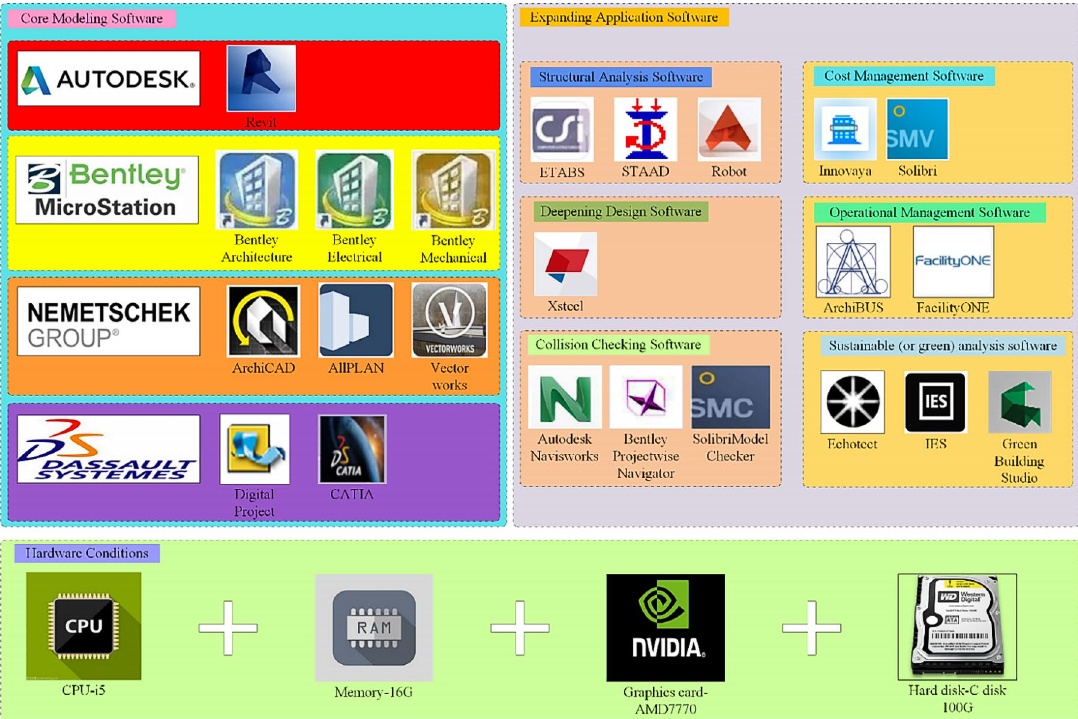
Figure 1. Diagram of hardware and software conditions for BIM technology